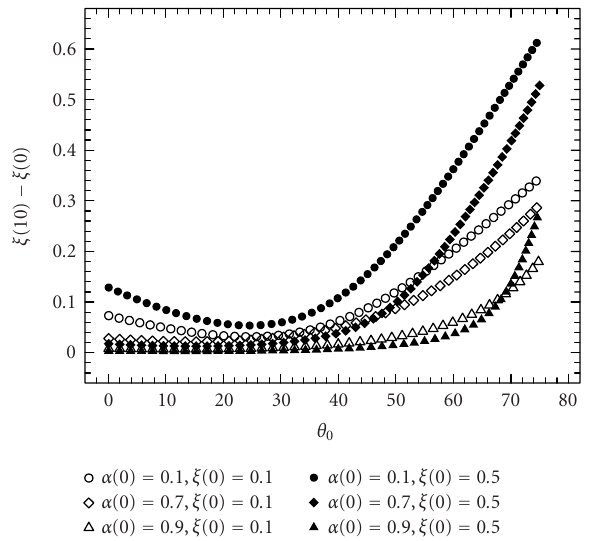
Figure 16: The computed compressor total pressure ratio versus inlet incidence